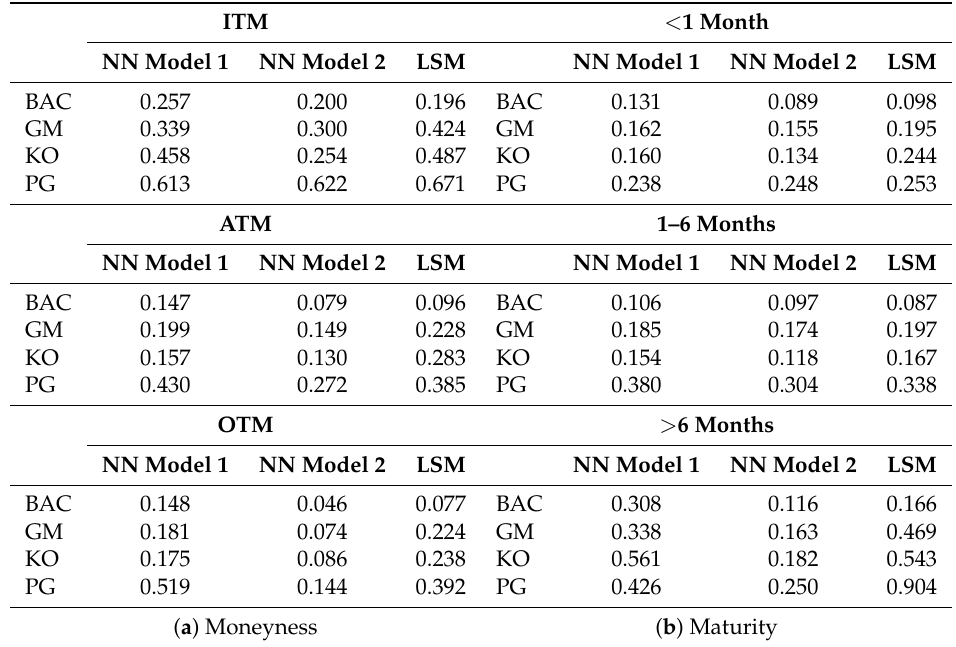
Table 7. RMSE per company: moneyness and maturity.